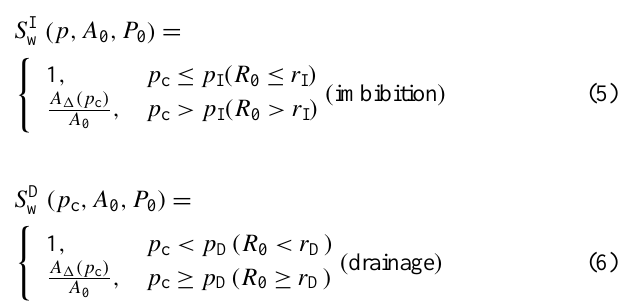
can be calculated according